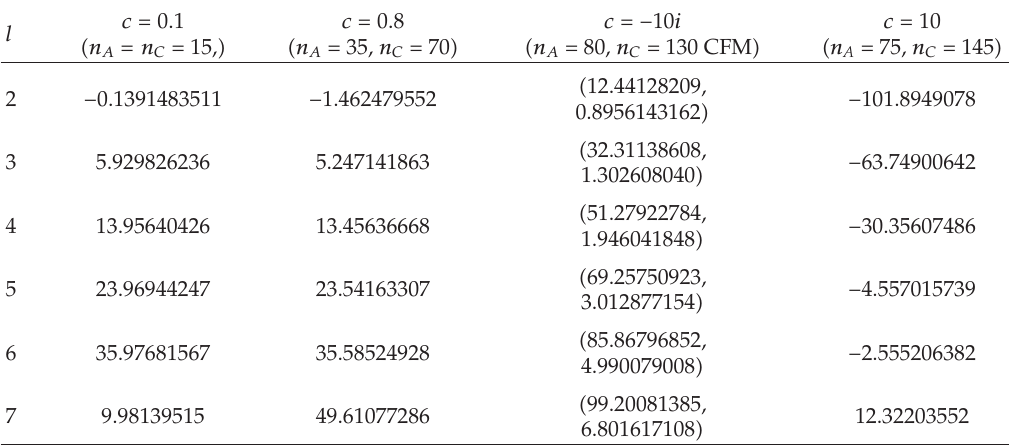
Table 13: Selected spin two eigenvalues, 2 A lm , obtained from the AIM for a Kerr black hole with varying values of c (cid:8) aω and m (cid:8) 1: the same number of iterations in the AIM, n A , and the number of recursions in the CFM, n C , for c (cid:8) 0 . 1 , 0 . 8 at a working precision of 15 digit precision, where results are presented to